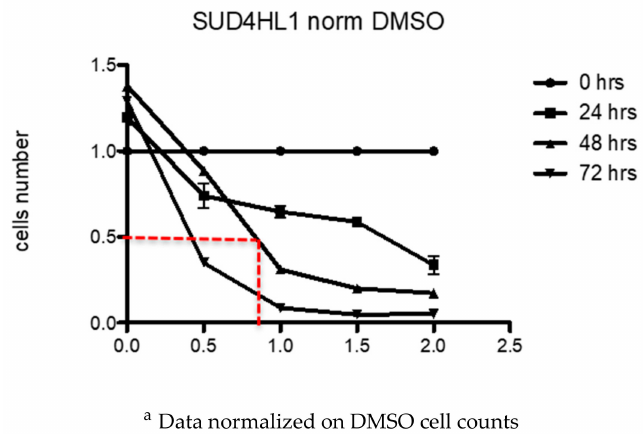
Figure 9. Determination of IC 50 of compound 2 in SU-DHL4 cells (0.8 µ M, 48 h; 0.45 µ M, 72 h). Data are normalized on DMSO cell counts.